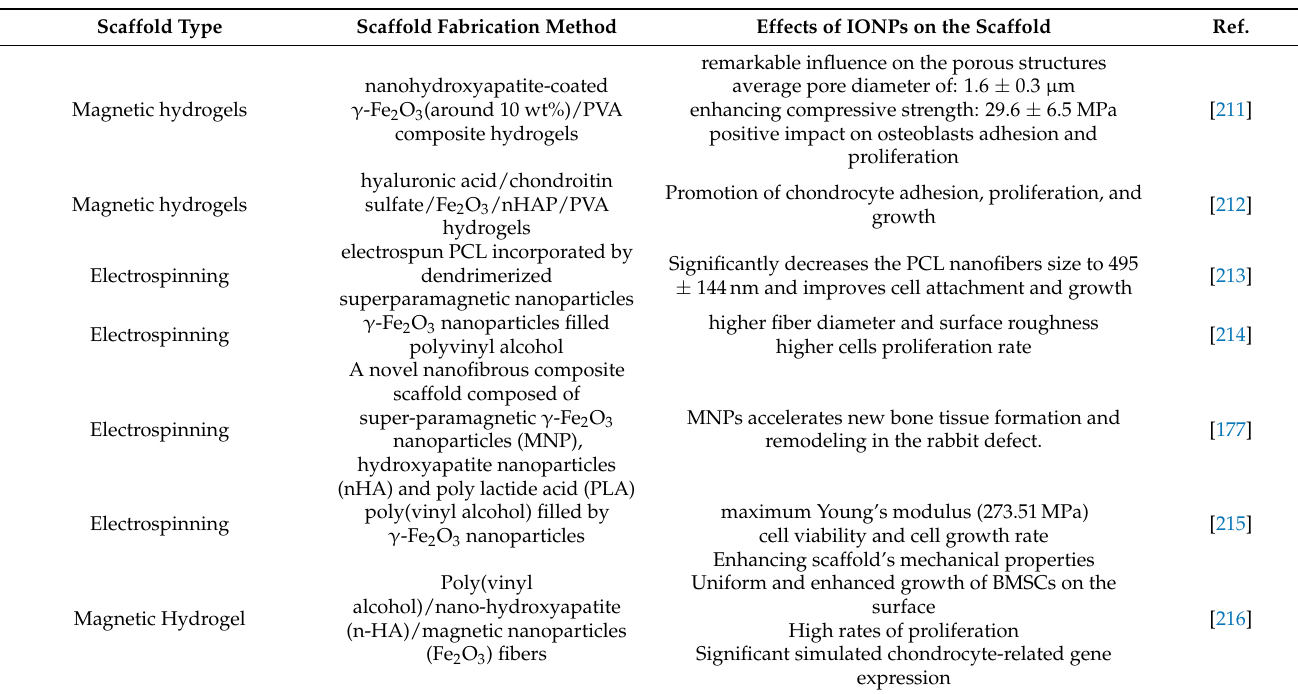
Table 2. The scaffolds fabrication methodology, their characteristics and the effect of the presence of IONPs on their properties, and potential clinical translations have been